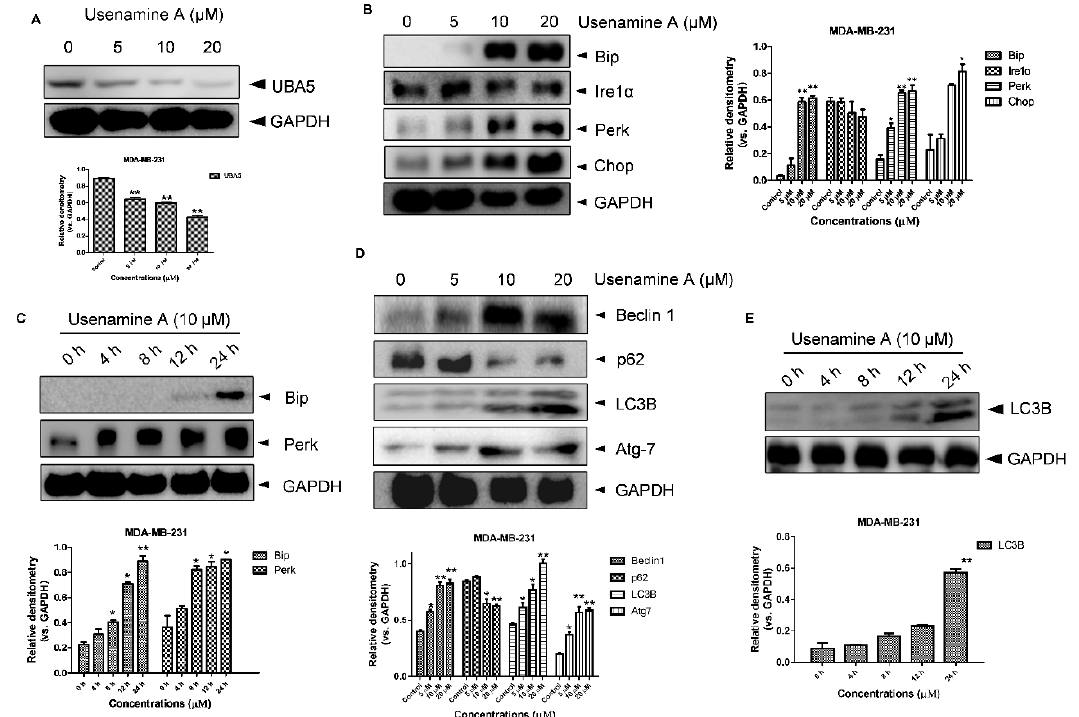
Figure 5. Usenamine A-induced ER stress and autophagy in MDA-MB-231 cancer cells. ( A ) Western blotting analysis of UBA5 expression in MDA-MB-231 cells. The cells were incubated with different concentrations of usenamine A (5, 10, and 20 µ M) for 48 h. ( B ) Western blotting analysis of ER stress-related proteins in MDA-MB-231 cells. The cells were cultured for 48 h in standard growth medium and incubated with different concentrations of usenamine A (5, 10, and 20 µ M). ( C ) Western blotting analysis of ER stress-related proteins in MDA-MB-231 cells. The cells were cultured in standard growth medium and incubated with the developed drug (10 µ M) for various times (0, 4, 8, 12, 24 h). ( D ) Western blotting analysis of autophagy-related proteins in MDA-MB-231 cells. The cells were incubated with different concentrations of usenamine A (5, 10, and 20 µ M) for 48 h. ( E ) Representative western blot of autophagy-related proteins in MDA-MB-231 cells. The cells were cultured in standard growth medium and incubated with the developed drug (10 µ M) for various times (0, 4, 8, 12, 24 h). Fetal bovine serum (FBS) was used as a supplement to culture MDA-MB-231 cells. * p < 0.05, ** p < 0.01 and *** p < 0.001 compared to the control